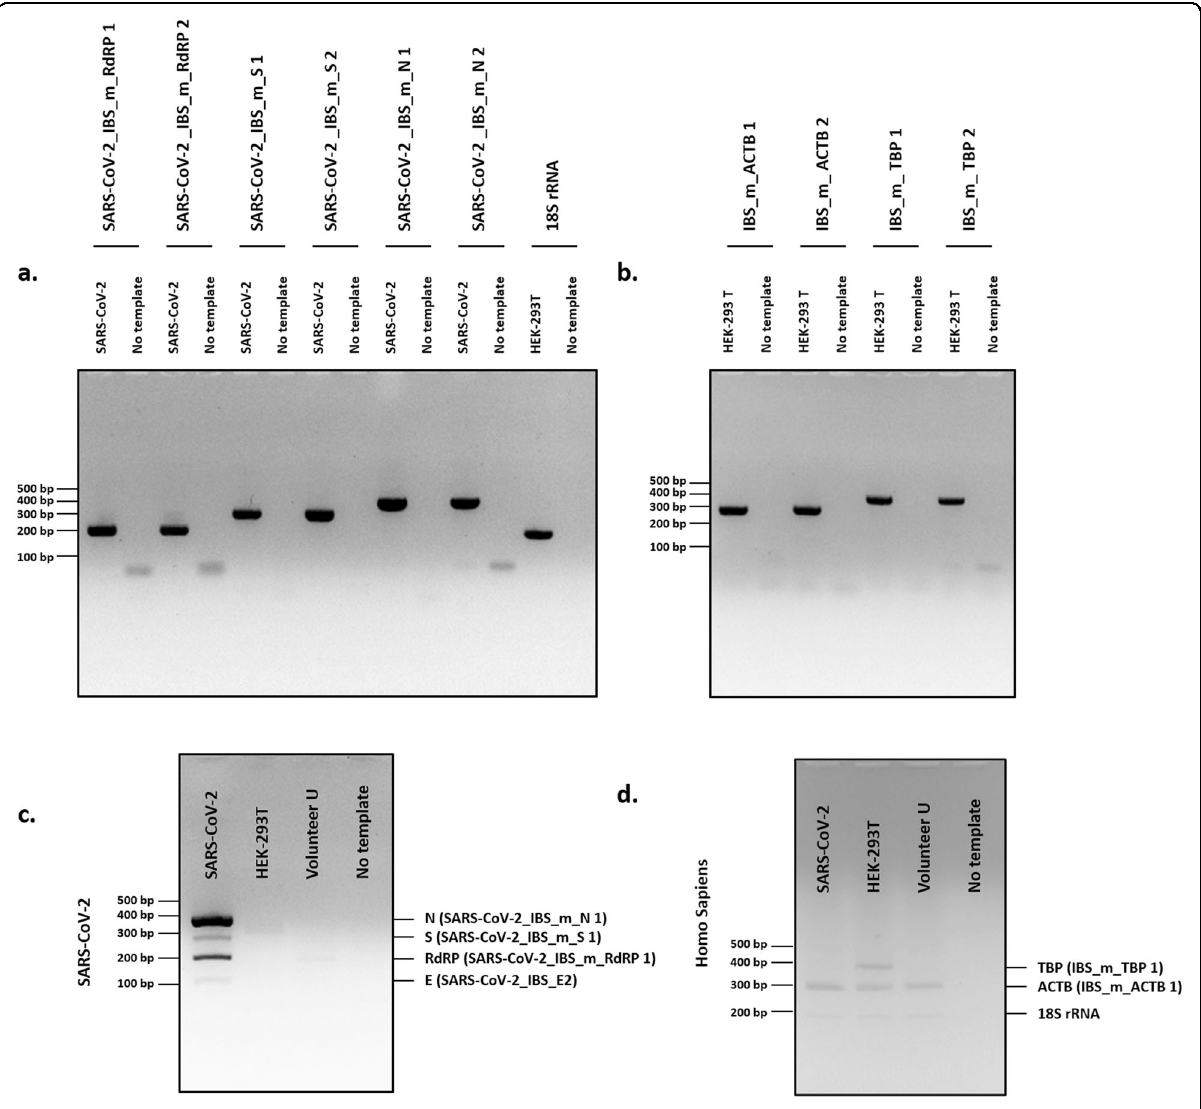
Fig. 6 Optimization and development of a multiplex PCR protocol for SARS-CoV-2 detection. a , b Gel electrophoresis results from PCR with the primer sets SARS_CoV-2_IBS_m_RdRP 1, SARS_CoV-2_IBS_m_RdRP 2, SARS_CoV-2_IBS_m_S 1, SARS_CoV-2_IBS_m_S 2, SARS_CoV-2_IBS_m_N 1, SARS_CoV-2_IBS_m_N 2, 18S rRNA, IBS_m_ACTB 1, IBS_m_ACTB 2, IBS_m_TBP 1, and IBS_m_TBP 2. Expected PCR product sizes are indicated in Table 1. c , d Gel electrophoresis results obtained from multiplex PCR in the SARS-CoV-2, HEK-293T, Voulteer U, and no-template reactions by using a mixture of four primer sets for c SARS-CoV-2 detection (SARS-CoV-2_IBS_E2, SARS-CoV-2_IBS_m_RdRP 1, SARS-CoV-2_IBS_m_S 1, and SARS-CoV- 2_IBS_m_N 1). d A mixture of three primer sets was used to detect human IPC (IBS_m_TBP 1, IBS_m_ACTB 1, and 18S rRNA). The location of each predicted PCR product in the gel is indicated on the right